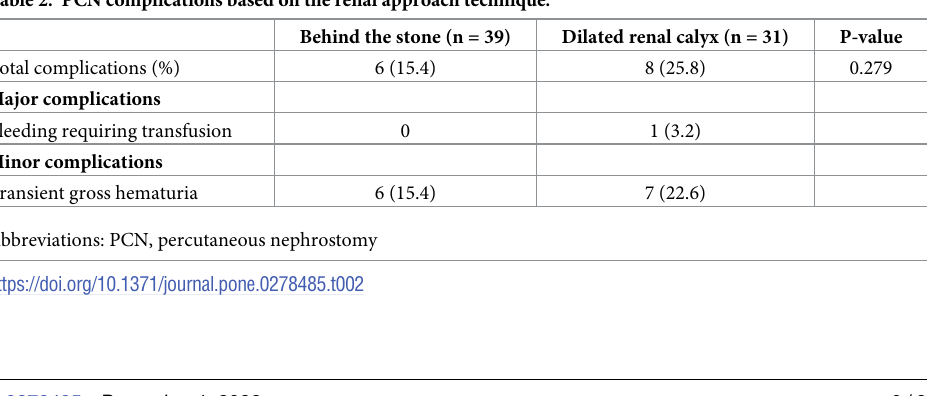
Table 2. PCN complications based on the renal approach